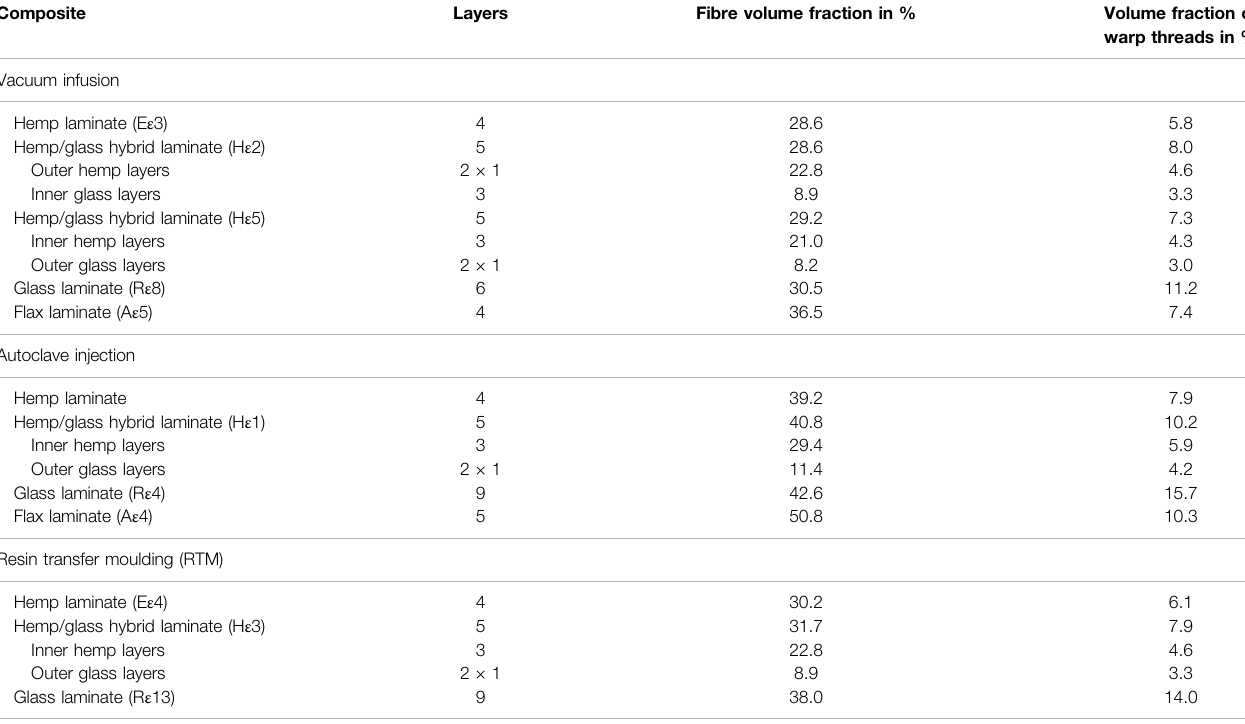
TABLE 3 | Construction and composition of composite laminates (hybrid materials are symmetrically constructed; designations in brackets with Greek letters indicate internal project labels). Composite